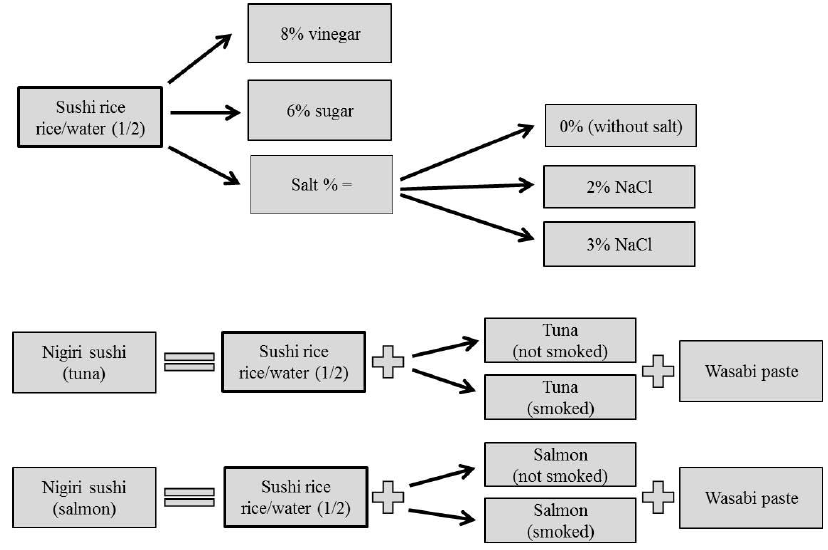
Figure 1. Experimental design of sushi production samples used in the research. Table 1. Ingredients’ portions (%) of nigiri sushi prepared with salmon and